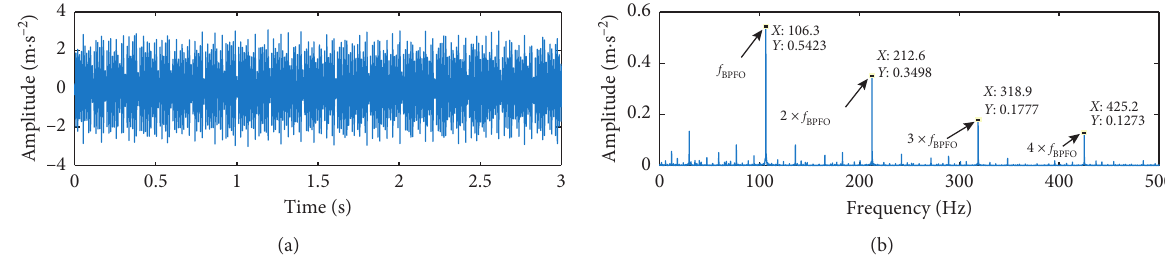
Figure 13: Experimental signal for a localized fault being 0.007 inches under 1772rpm. (a) Experimental signal in time domain. (b) Experimental signal in frequency domain.